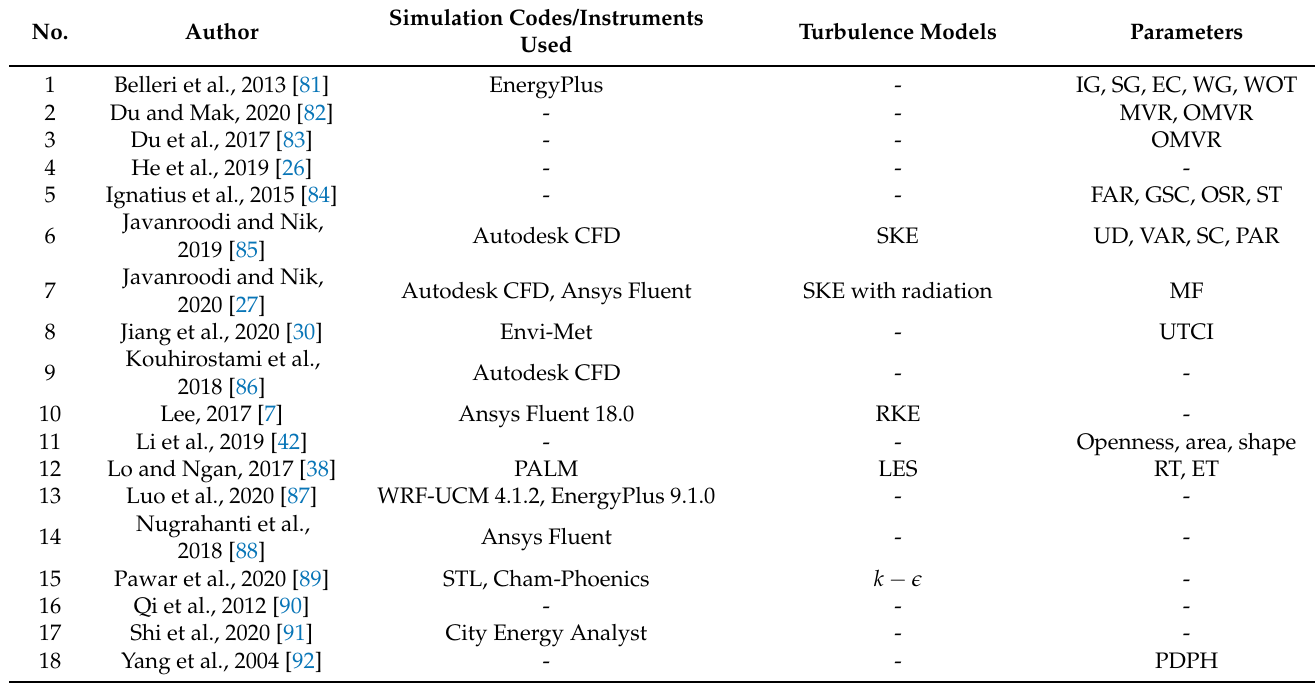
Table 9. Overview of studies of real urban areas with validation comparison with experimental or numerical data: adopted simulation codes, turbulence models and parameters.